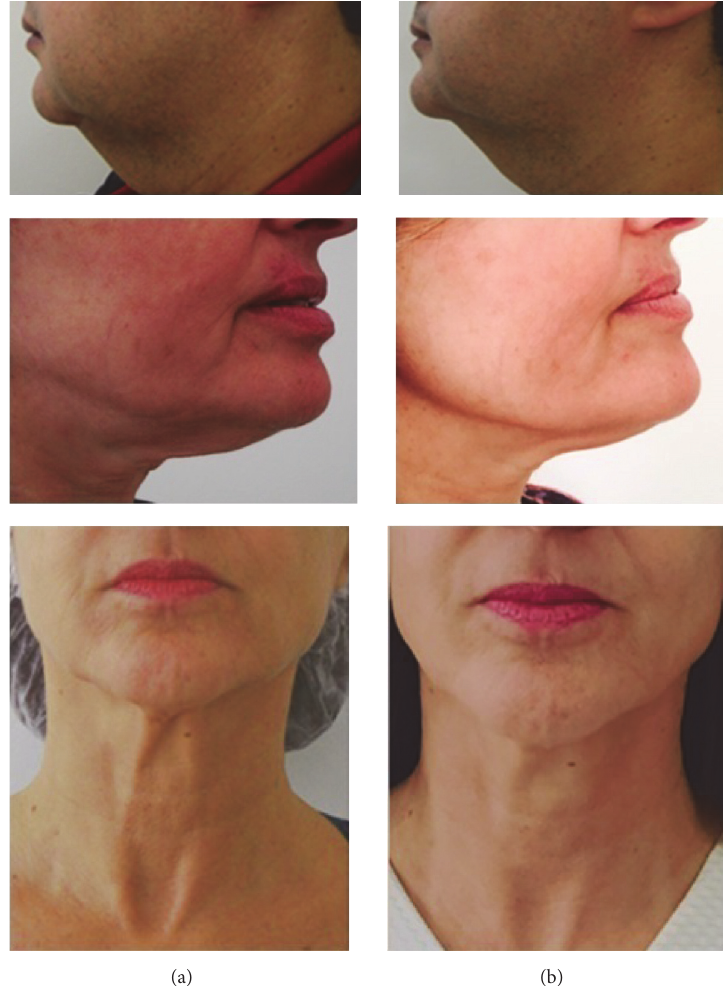
Figure 3: Improvements in skin condition. Photographs of selected patients before (a) and after eight sessions (b) of treatment with RF and